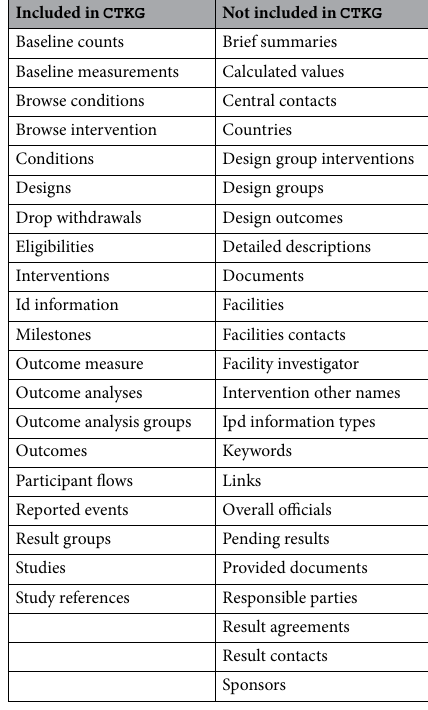
Table 9. AACT tables included and not included in CTKG